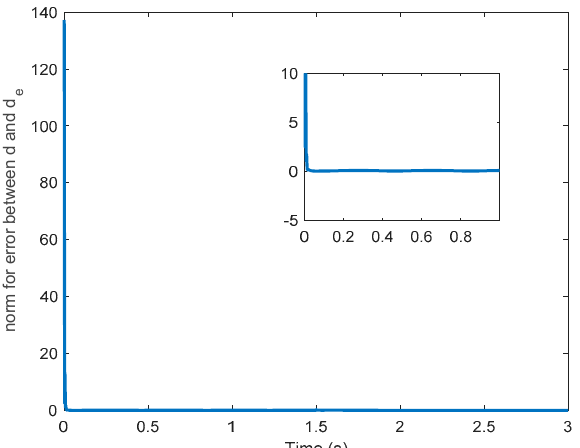
Mathematics 2019 , 7 , x FOR PEER REVIEW 17 of 21